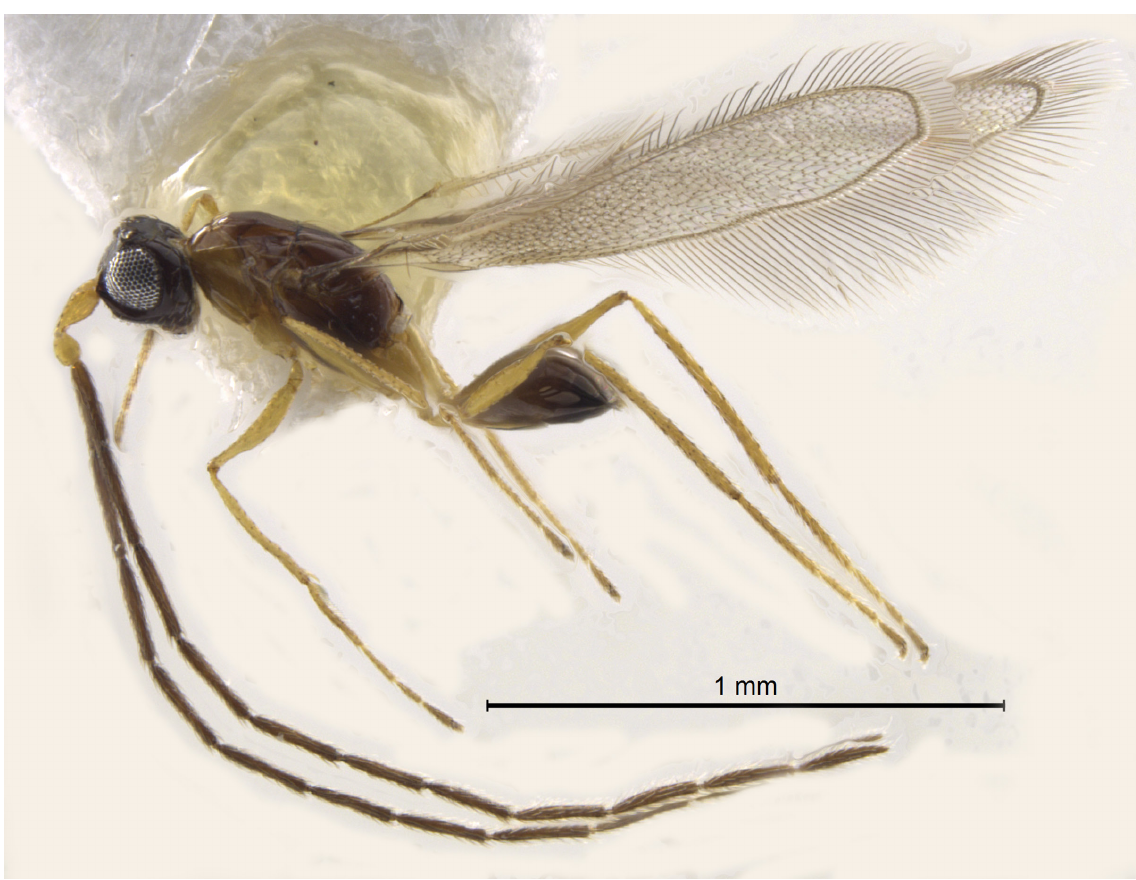
Fig. 4. Ganomymar caslot sp. nov., ♂, paratype (CASENT 2079171), habitus in lateral